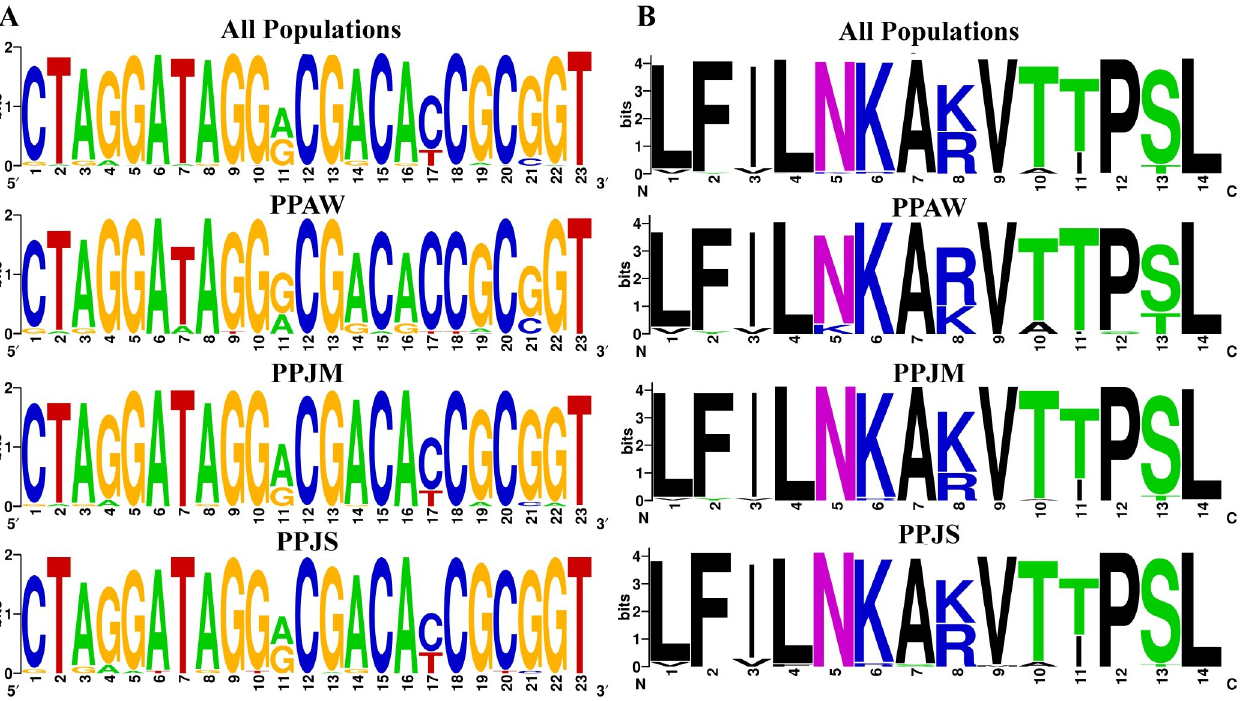
Fig 5. PpSP14 nucleotide and amino acid variation. (A) Weblogo illustrating the relative frequencies of nucleotide polymorphisms in wild caught P . papatasi populations from PPAW, PPJM, and PPJS. (B) Weblogo illustrating the relative frequencies of amino acid polymorphisms in wild caught P . papatasi populations from PPAW, PPJM, and PPJS.